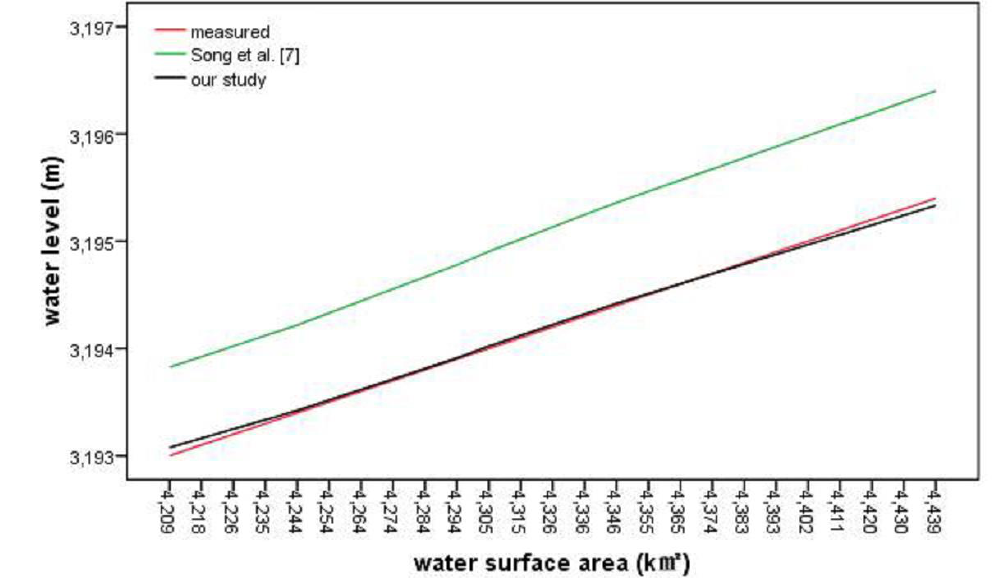
Figure 15. Comparison of the L-A curves established in different